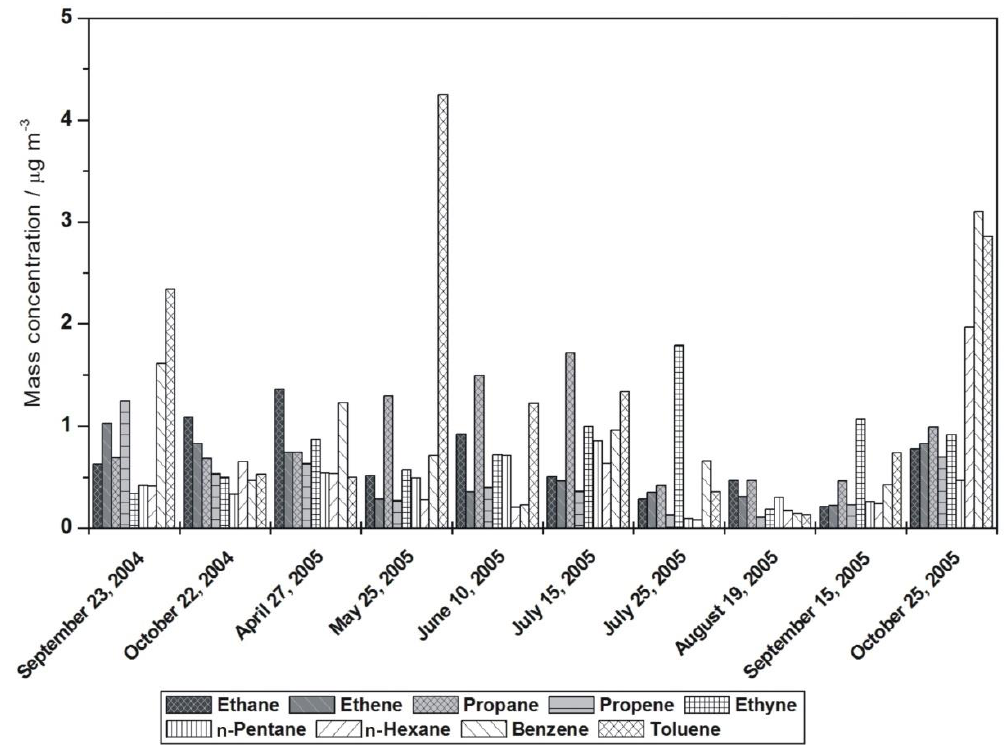
Figure 2. Average daily value of the mass concentration of some hydrocarbons measured at Mali Lošinj in 2004 and 2005.